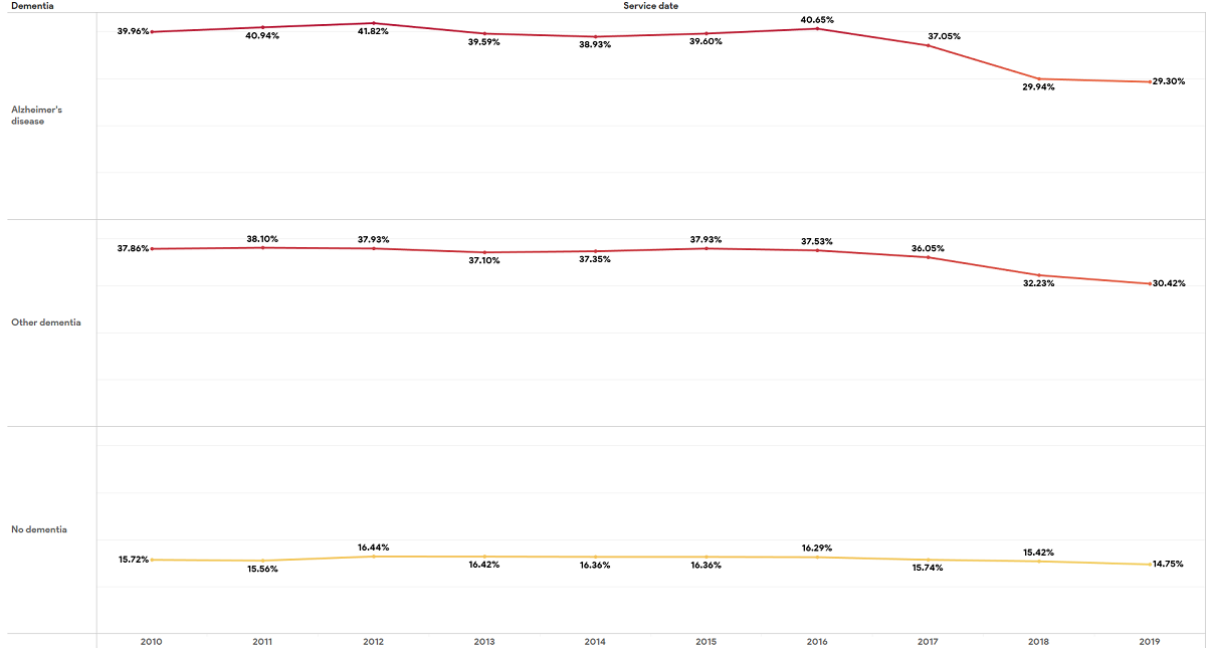
Figure 3. Tableau dashboard showing the trend in the percentage of patients with at least 1 benzodiazepine prescription between 2010 and 2019 by dementia